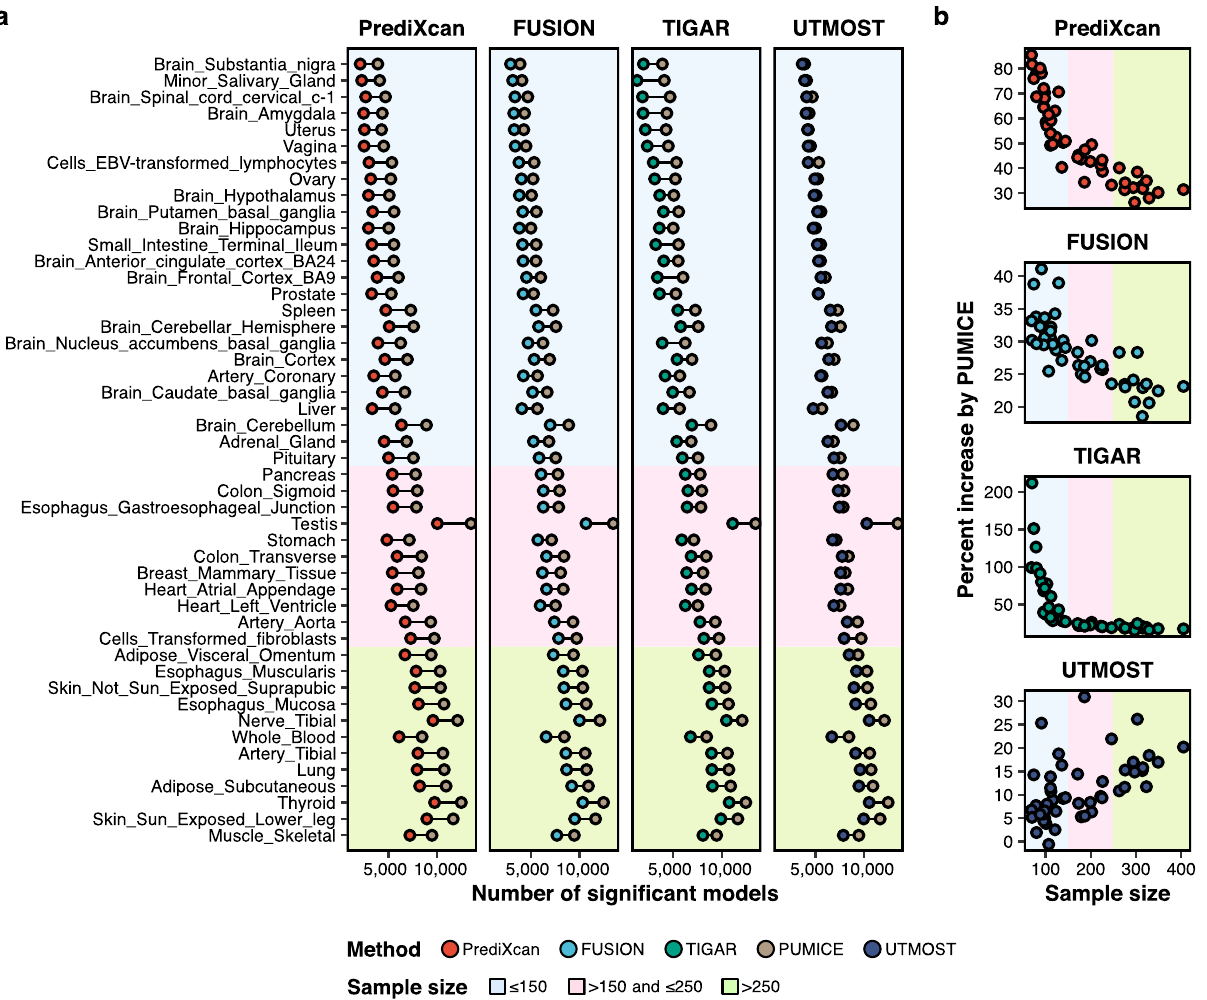
Fig. 2 Comparison of PUMICE gene expression prediction models to other TWAS methods. In panel ( a ), we compare the number of PUMICE signi fi cant models to other TWAS methods, including PrediXcan, FUSION, TIGAR, and UTMOST, across 48 GTEx tissues. Across all scenarios, PUMICE achieves higher number of signi fi cant models than those of other single-tissue TWAS methods. In comparison to UTMOST, PUMICE achieves comparable number of models in small sample size tissues, but achieves higher number of models in large sample size tissues. In panel ( b ), we illustrate the percent increase in signi fi cant models between PUMICE and other TWAS methods. Comparing to other single tissue TWAS methods, percent increase of models gets larger for smaller training sample size. In comparison to UTMOST, percent gain of models gets larger for larger training sample